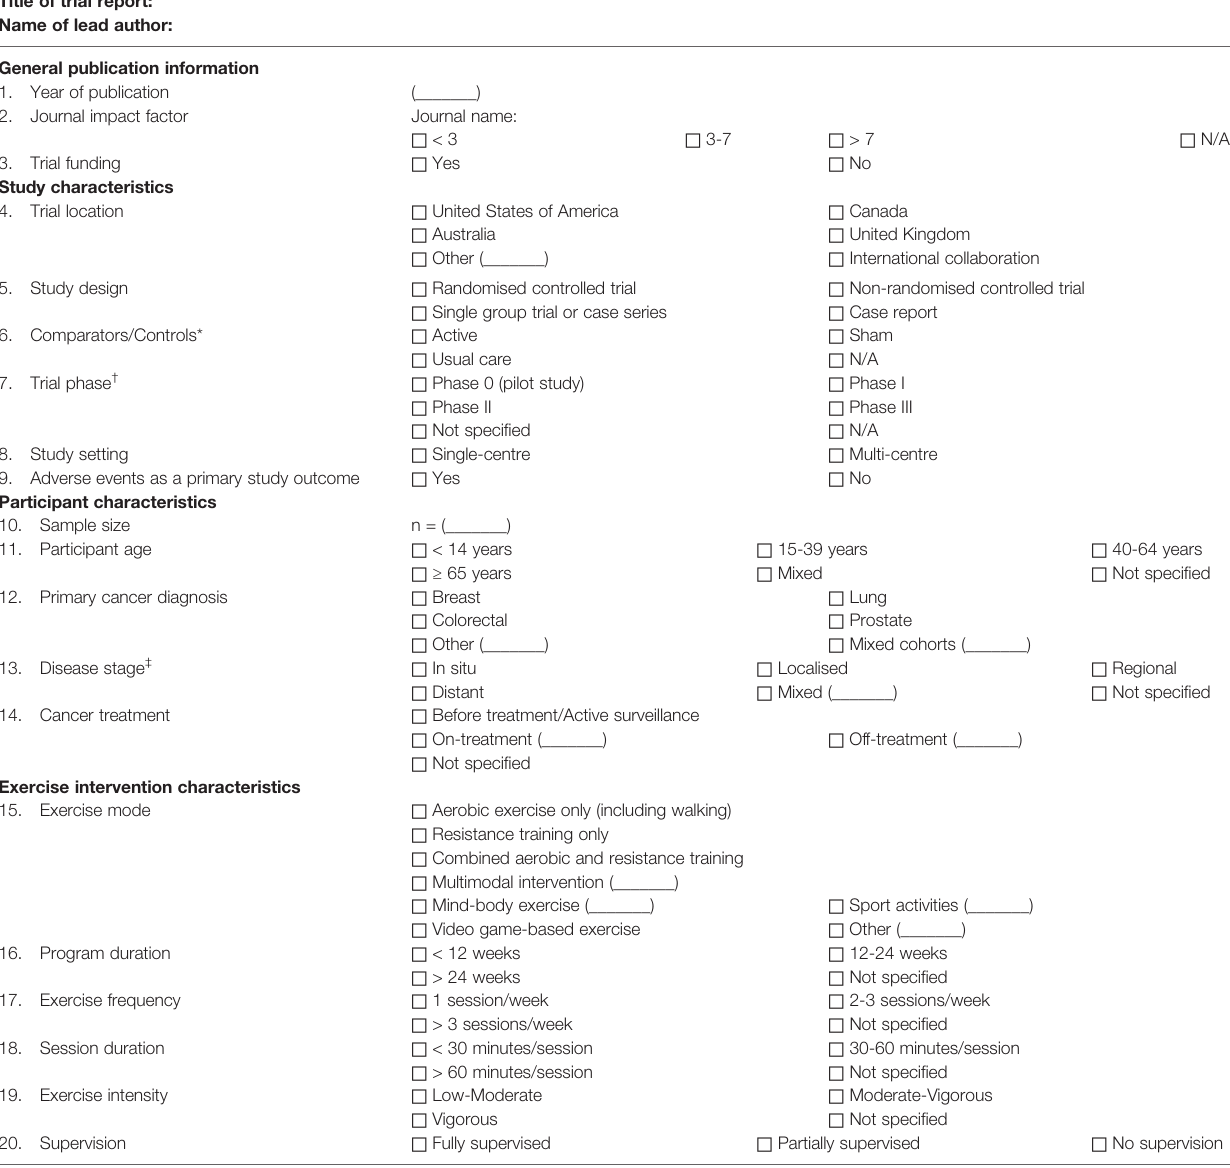
TABLE 2 | Data extraction form for trial